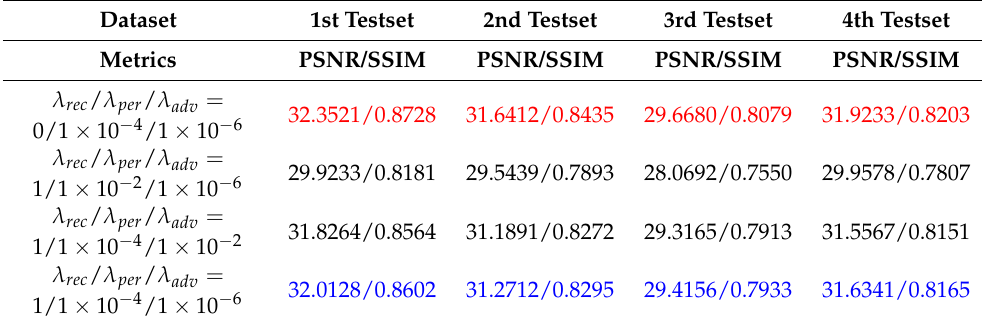
Table 6. Results of average PSNR and SSIM results of different SVD coefficients on four test sets. Red index denotes the best performance. Blue index suggests the suboptimal performance. Dataset 1st Testset 2nd Testset 3rd Testset 4th